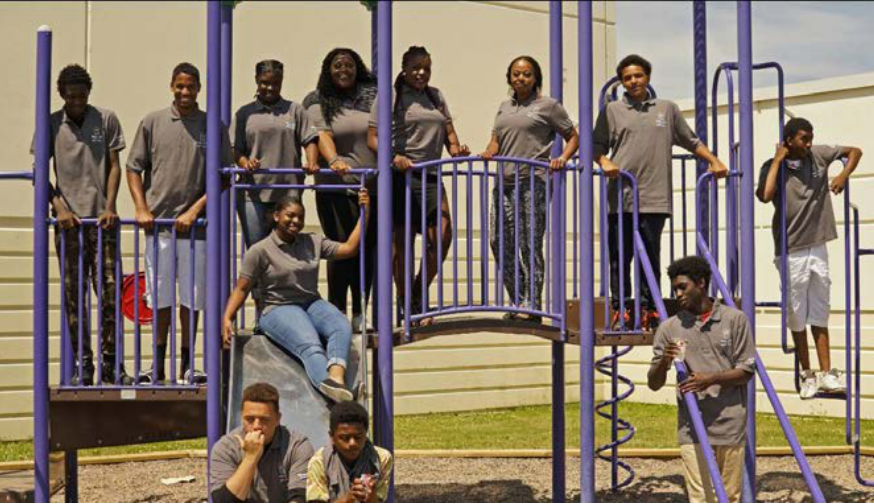
Figure 10. North Preston youth, 2016. Photo by Miranda Cain.